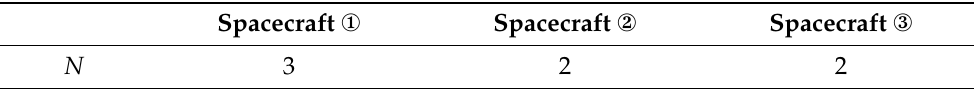
Table 2. Number N of revolutions of the rotating reference system corresponding to each iterative cycle, see Equation (13) with (cid:101) = 10 − 3